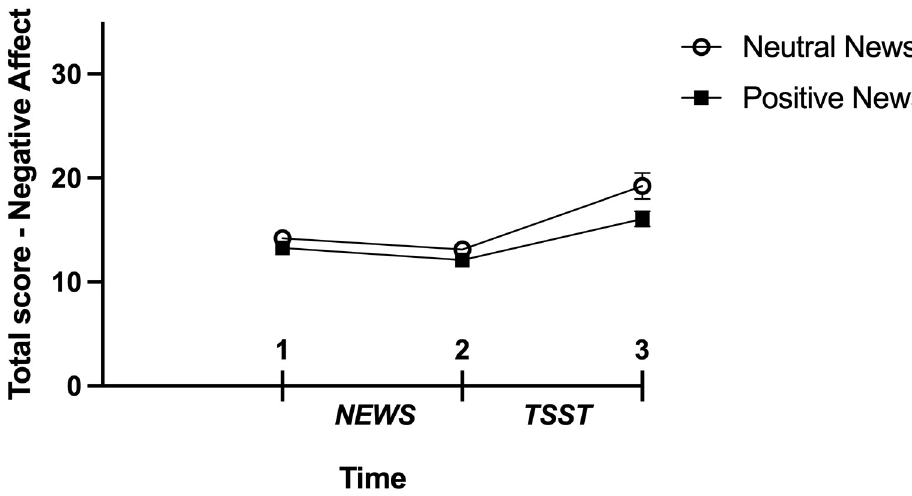
Fig 6. Score on negative affect, PANAS’s subscale in function of time as a function of condition. Non-adjusted means are presented and errors bars are the standard error of the mean.